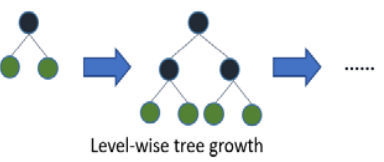
Figure 2. Schematic diagram of level wise strategy growth tree .